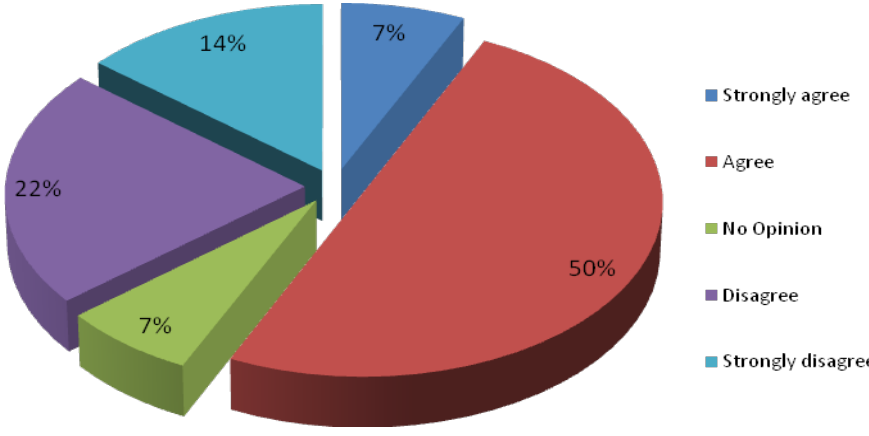
Figure 1 Developing a cloud collaboration tool based on combining open API’s of accountancy, project management, and BIM